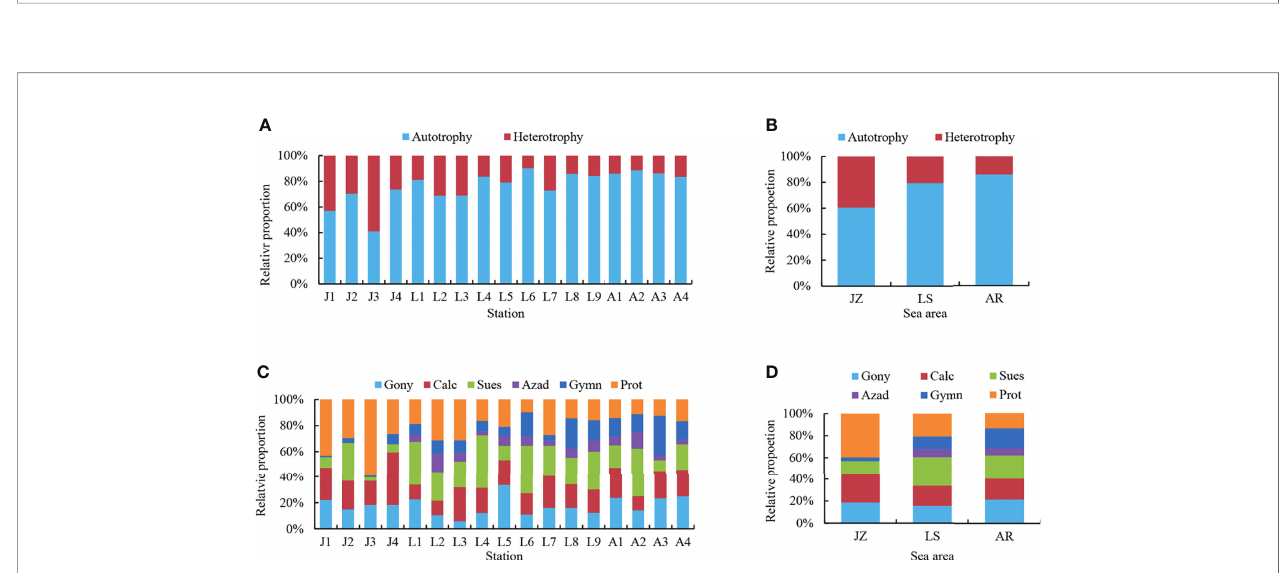
FIGURE 4 | Cyst pro fi le in the seventeen samples (A, C) and the three sea areas (B, D) . (A, B) Percentage proportions of cysts of autotrophic and heterotrophic dino fl agellates. (C, D) Percentage proportions of cysts of each dino fl agellate group. Gony, Gonyaulacales; Calc, Calciodinelloideae; Sues, Suessiales; Azad, Azadinium (Dinophyceae incertae sedis); Gymn, Gymnodiniales; Prot,